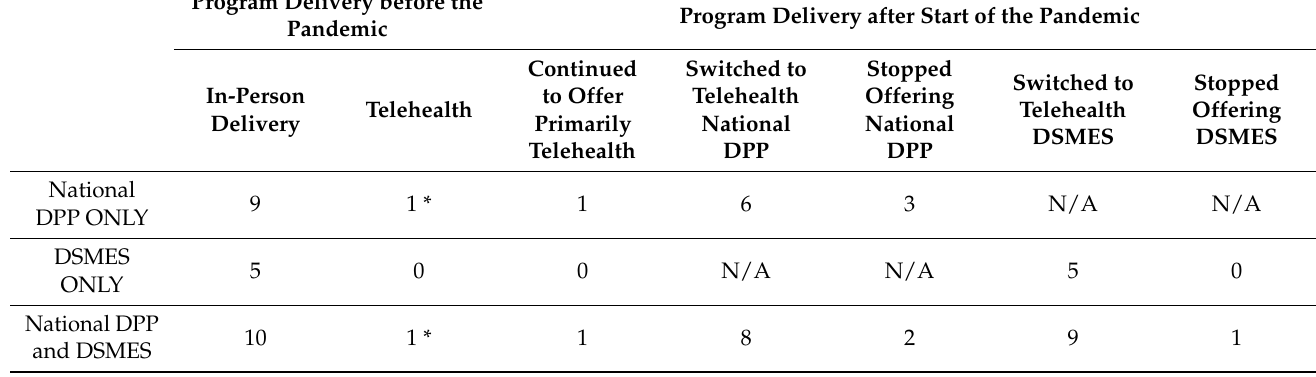
Table 1. National Diabetes Prevention Program and Diabetes Self-Management Education